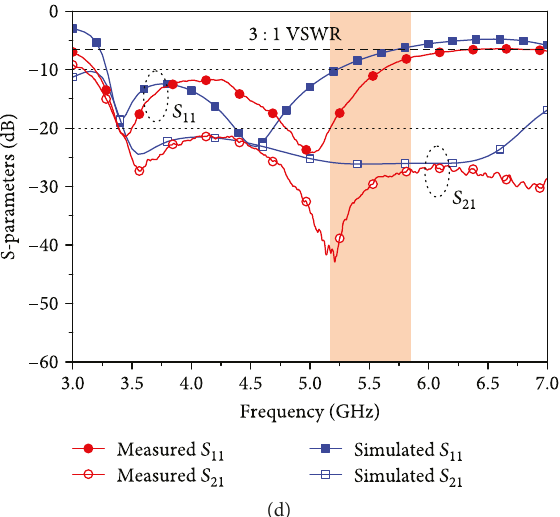
(d) Figure 3: (a) Con fi guration of the two-element MIMO antenna at angle θ in free space. (b) Measured S 11 and S 21 at di ff erent degrees of bending for the two-element MIMO antenna in free space. (c) Measured radiation pattern for the two-element MIMO antenna bent at di ff erent angles in free space. (d) Measured and simulated S 11 and S 21 at the bending angle of 30 ° with the watchstrap for the MIMO antenna.